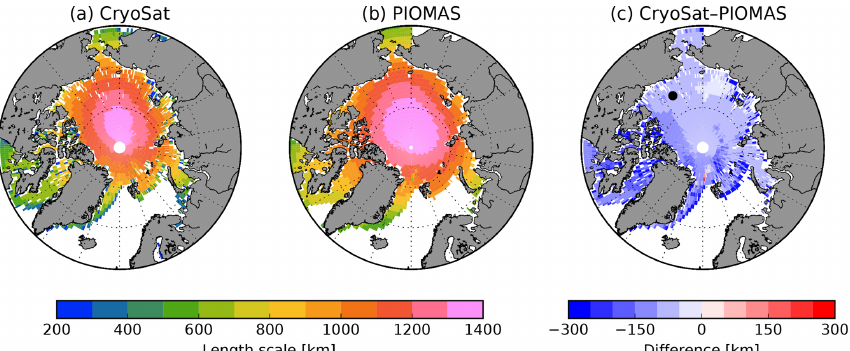
Figure 3. (a) The e -folding length scale estimated from the CryoSat seasonal data of sea ice thickness. This dataset contains 14 spring (March–April) and autumn (October–November) fields, starting in autumn 2010 and finishing in spring 2017. (b) Same as (a) , but using the equivalent temporal averages from the PIOMAS data. The difference between the fields shown in (a) and (b) is plotted in (c) . The black circle in (c) indicates the location of the mooring from which data are used in Fig.